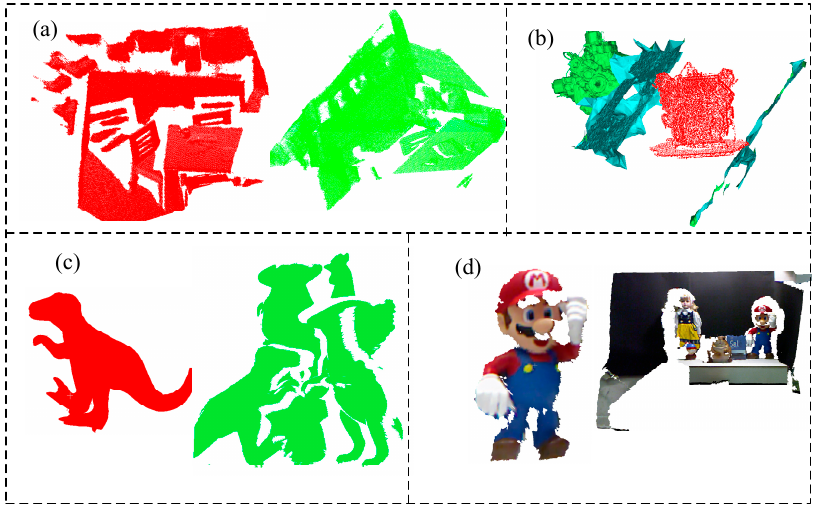
Figure 6. ( a ) Redkitchen dataset; ( b ) Engine; ( c ) UWA dataset: T-rex model and scene; ( d ) Kinect dataset: Mario and scene.